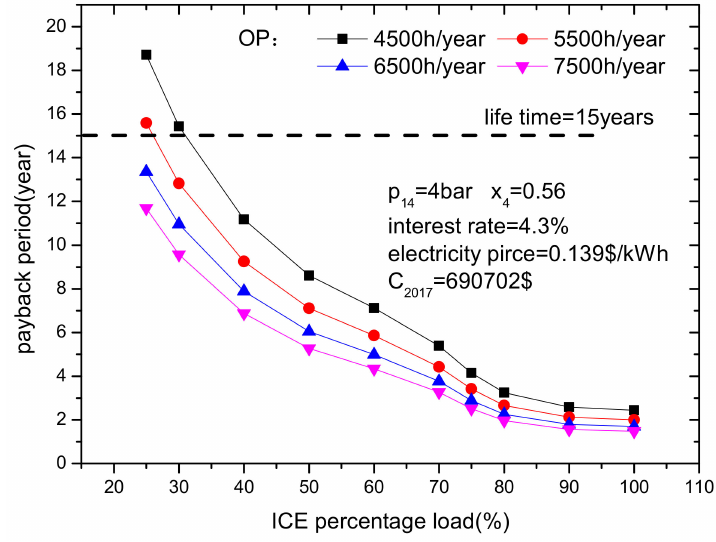
Figure 11. Minimum payback period at different ICE percentage loads.